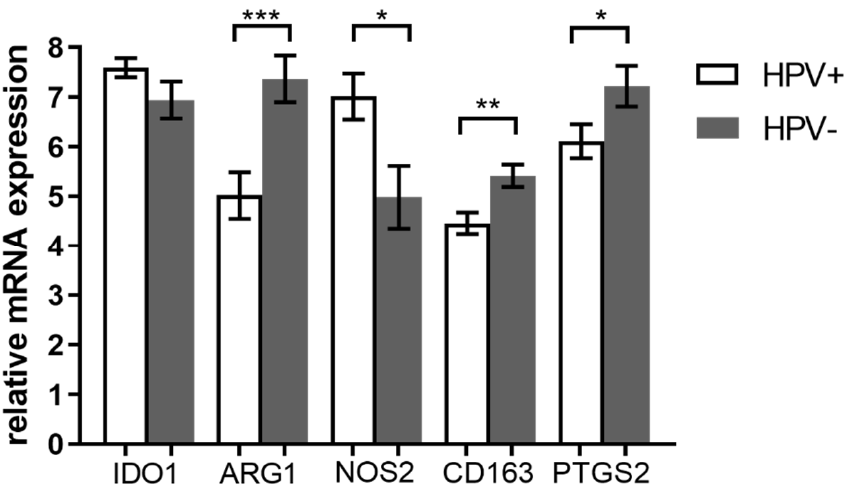
Figure 1. Comparison of gene expression in HPV+ and HPV − tumors. Relative mRNA expression of M1 and M2 tumor associated macrophage (TAM)-associated markers were compared in tumors with different etiology. Measured mRNA levels were normalized to GUS and ACTB reference genes using ∆∆ Ct approach. Significantly higher arginase 1 (ARG1), CD163, and prostaglandin-endoperoxide synthase 2 (PTGS2) mRNA levels were detected in the HPV − cohort (*** p = 0.0009 for ARG1, ** p = 0.0035 for CD163, and * p = 0.0402 for PTGS2 by unpaired t -test) and higher nitric oxide synthase 2 (NOS2) mRNA level was detected in the HPV+ cohort (* p = 0.0103 by unpaired t -test). Error bars—standard error of the mean.